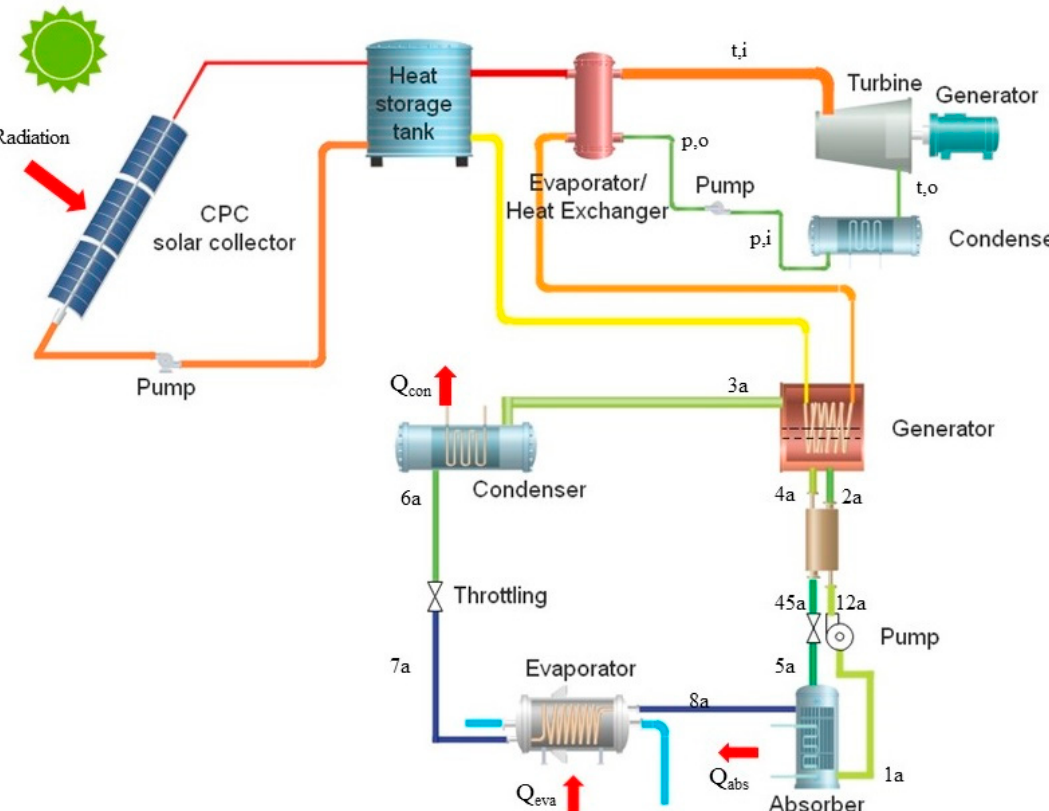
Figure 2. Schematic diagram of the series system (SS) for solar combined cooling, heating and power generation.